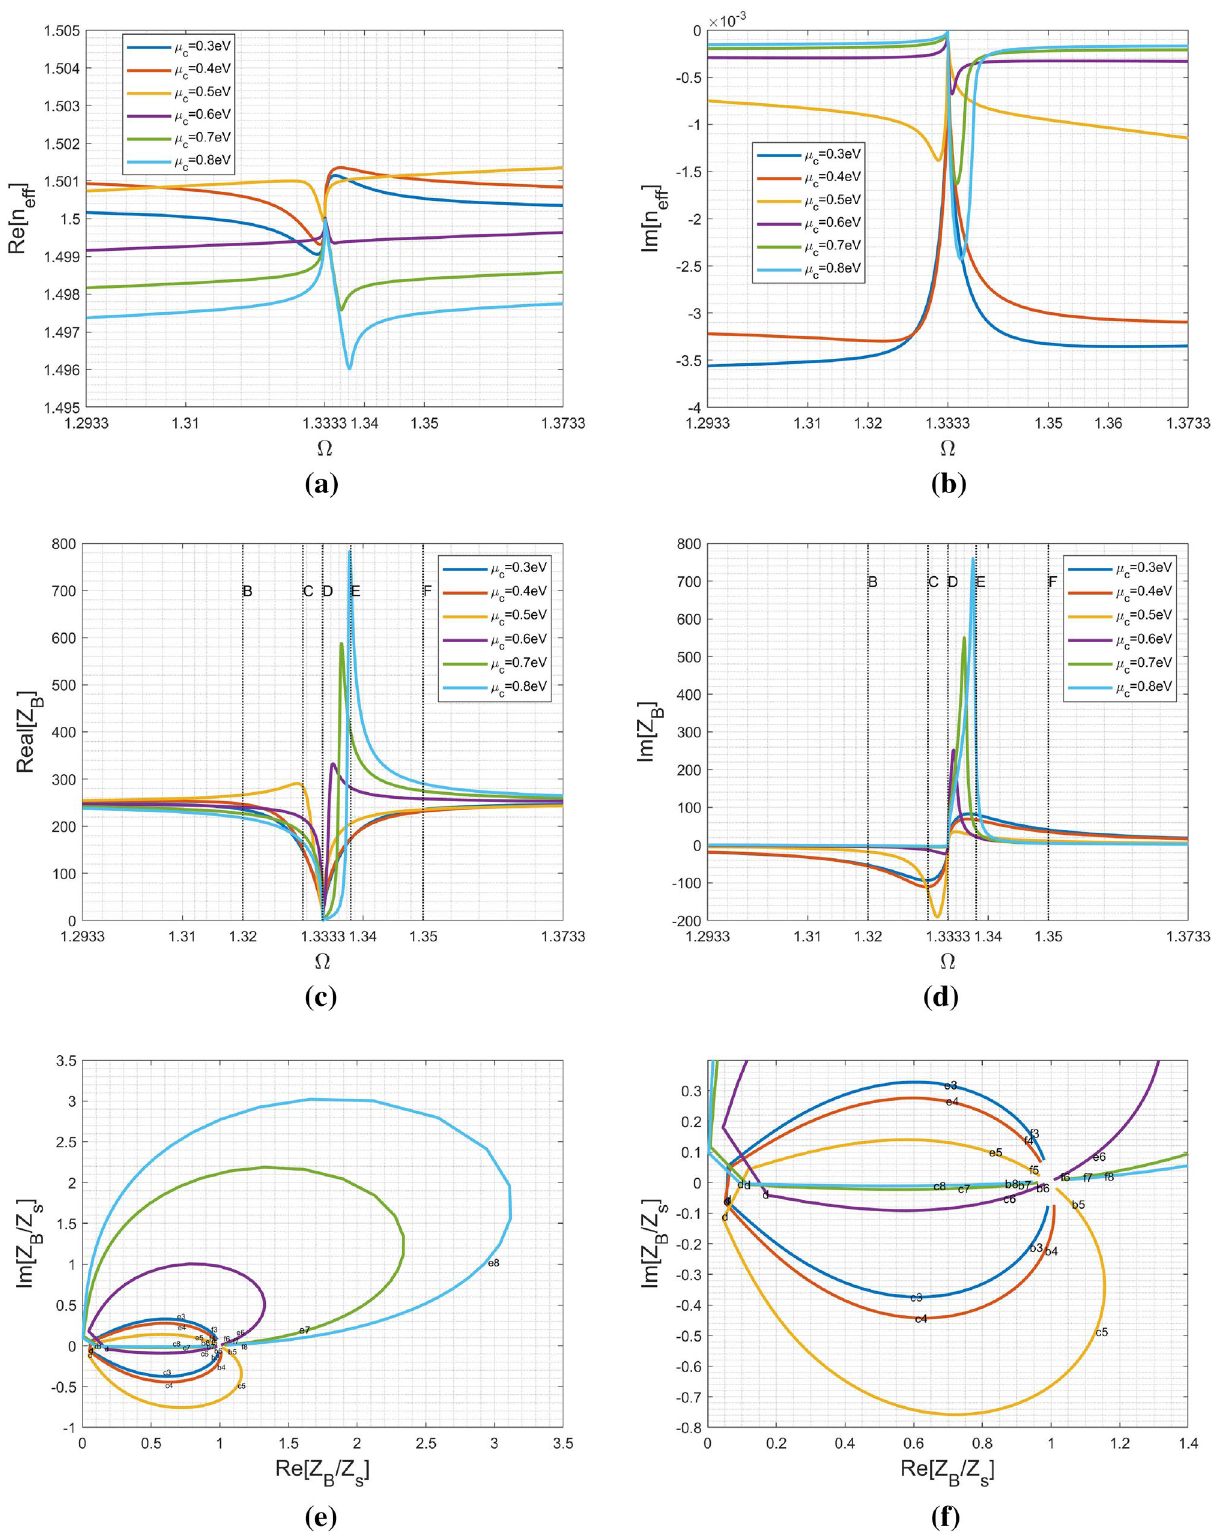
Figure 6. Effective refractive index and Bloch impedance against normalized angular frequency at around the first reflection peak of (cid:31) = 1.3333 : ( a ) real part of the effective refractive index, ( b ) imaginary part of the effective refractive index, ( c ) real part of the Bloch impedance, ( d ) imaginary part of the Bloch impedance, ( e ) the normalized Bloch impedance ( Z B / Z s ) plotted in a 2D plane, and ( f ) enlarged view of ( e ) around (cid:31) = 1.3333